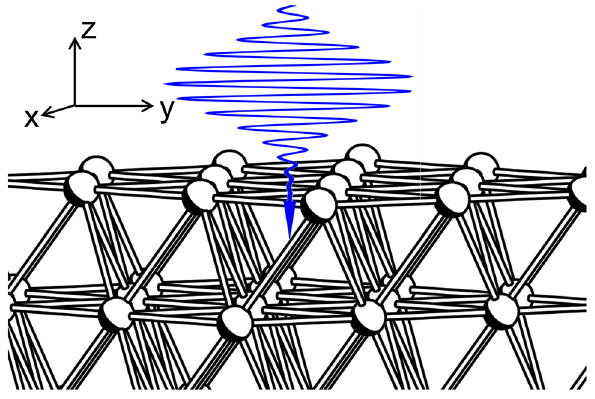
Figure 1. Slab model of a Cu(111) surface. The surface normal direction is along the z axis, the (111) crystallographic direction. Wavy line (blue) schematically denotes the incident laser with a polarization direction along the y axis, which is along a diagonal of the hexagonal cell of the Cu(111) surface, the ( − 1, 2, − 1 ) crystallographic